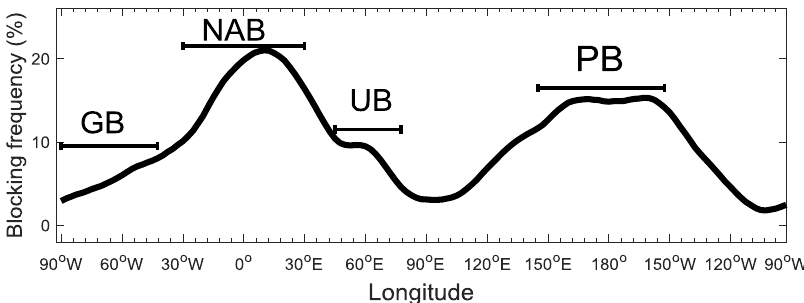
Figure 3. Percentage frequency of blocking as a function of longitude for winters from 1979–2016. GB, NAB, UB and PB represent Greenland blocking, North Atlantic blocking, Ural blocking and Pacific blocking, respectively.